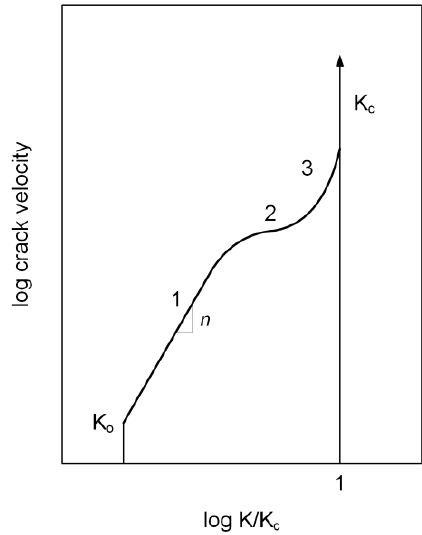
Figure 1. Diagram of crack velocity / normalised stress intensity factor for subcritical crack growth in rocks; K o represents the stress corrosion limit.